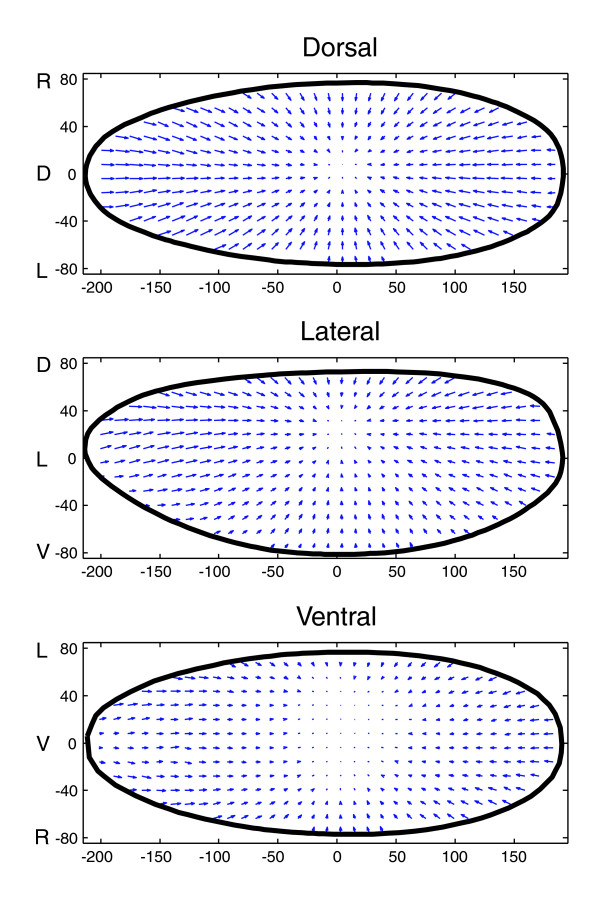
Predicted nuclear flow in the stage 5 blastoderm. The movement of nuclei in three dimensions was estimated using PointCloud data derived from fixed embryo material. Three orthographic projections of this model are shown, illustrating movement dorsally (top), laterally (center), and ventrally (bottom). The length and direction of arrows indicate the direction and distance of nuclear movement. The position on the y-axis of the dorsal midline (D), ventral midline (V), and left (L) and right (R) lateral midlines are indicated. On the x-axis, anterior is to the left and posterior to the right. The scale is in μm from the embryo center of mass. The predicted movements broadly agree with those seen in the live embryos, being greater at the poles and dorsally than ventrally. Note that the apparent movement towards the center of each view results from the basal movement of nuclei inward.